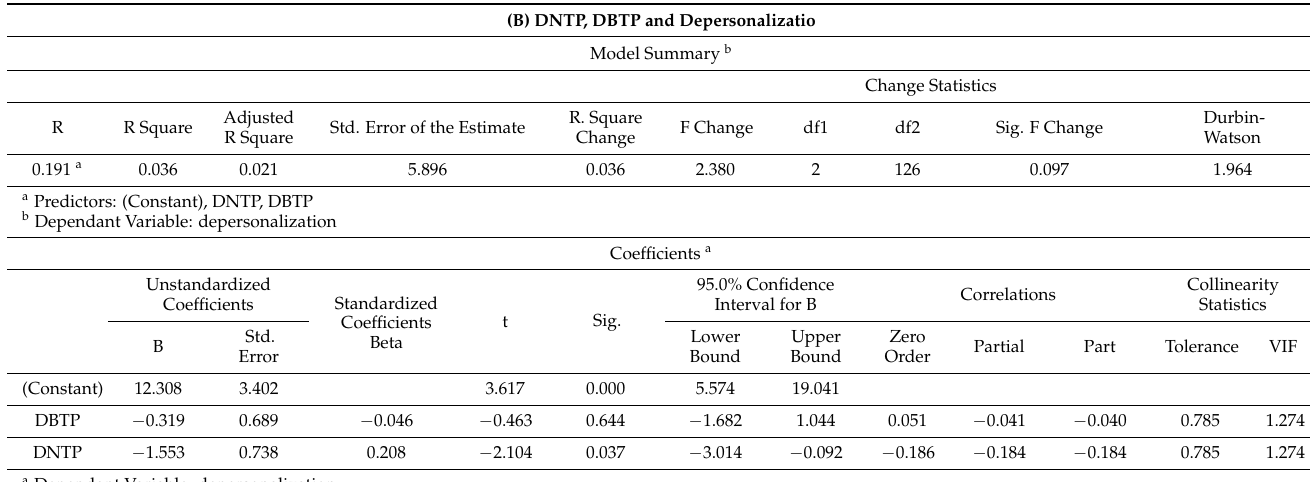
Table 7. Linear Regression of Depersonalization.